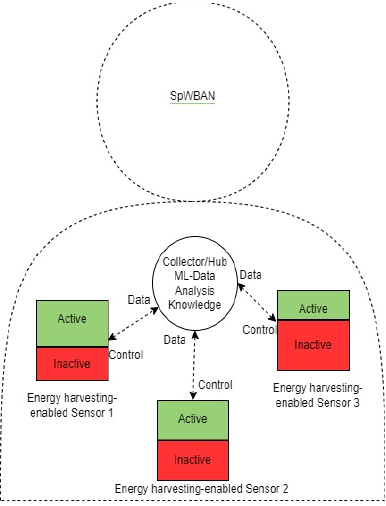
Figure 4. SpWBAN with smart machine learning-based operations. Figure 4. S pWBAN with smart machine learning-based operations. Algorithm 1 Smart Management of SpWBAN Operations by the Controller